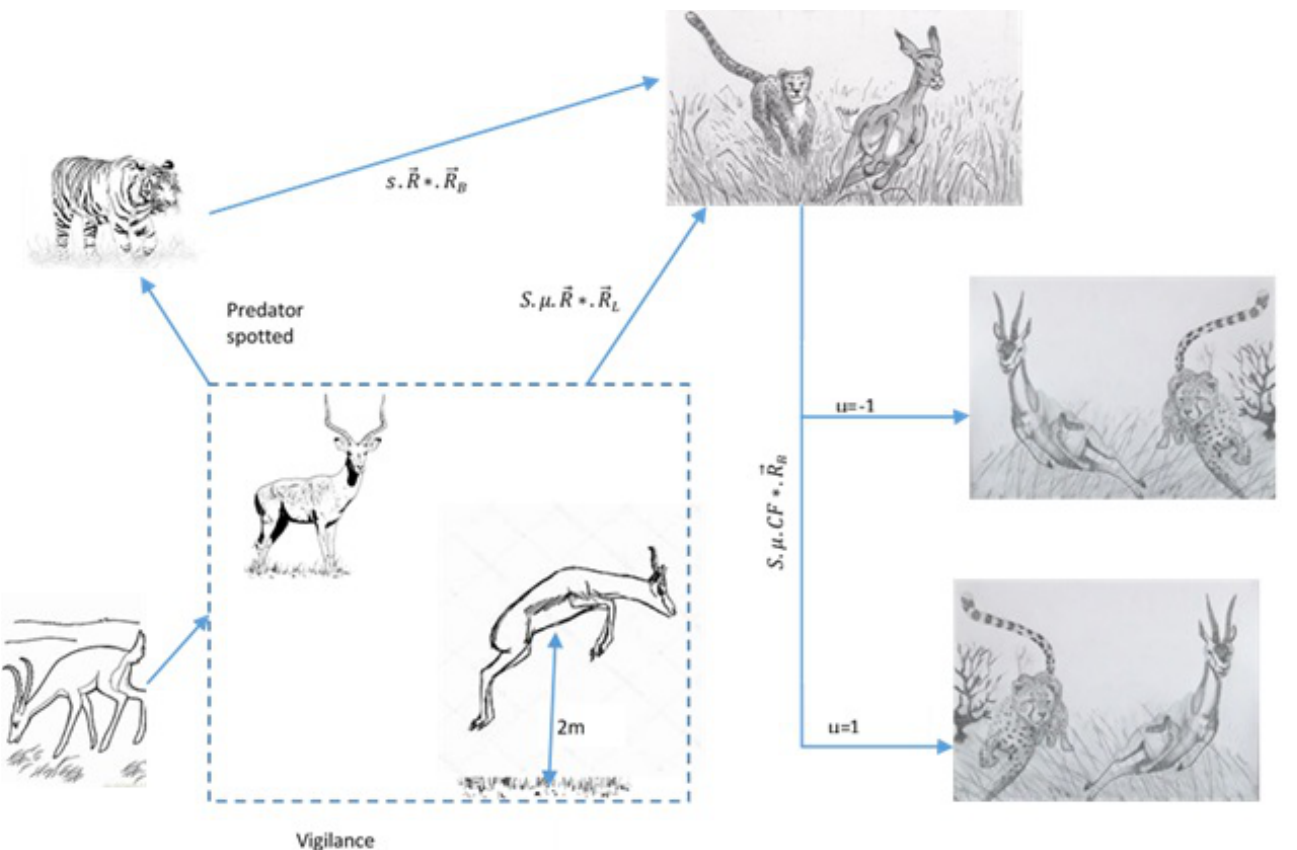
Figure 2. Gazelles fleeing the predator is a sign of